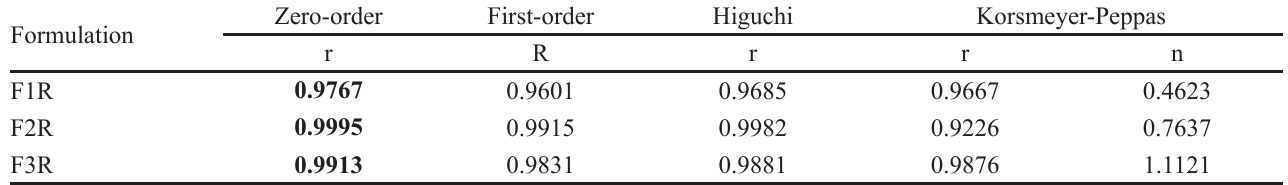
TABLE IV – Dissolution efficiency of formulations F1R, F2R